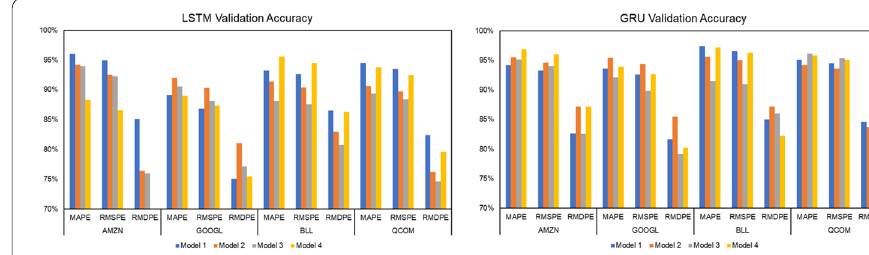
Fig. 14 Visualization graph of LSTM and GRU validation